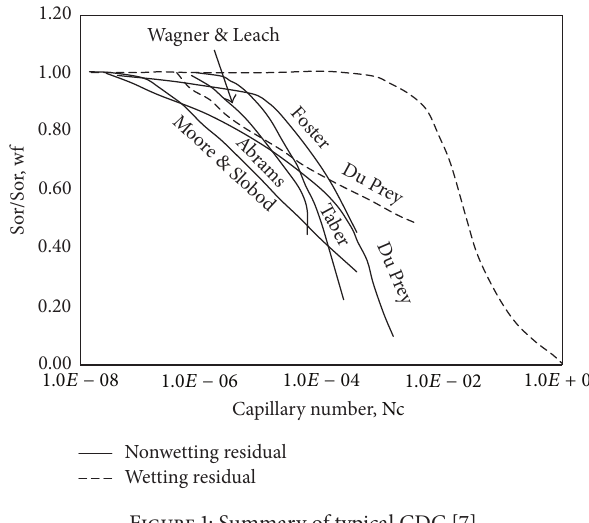
Figure 1: Summary of typical CDC